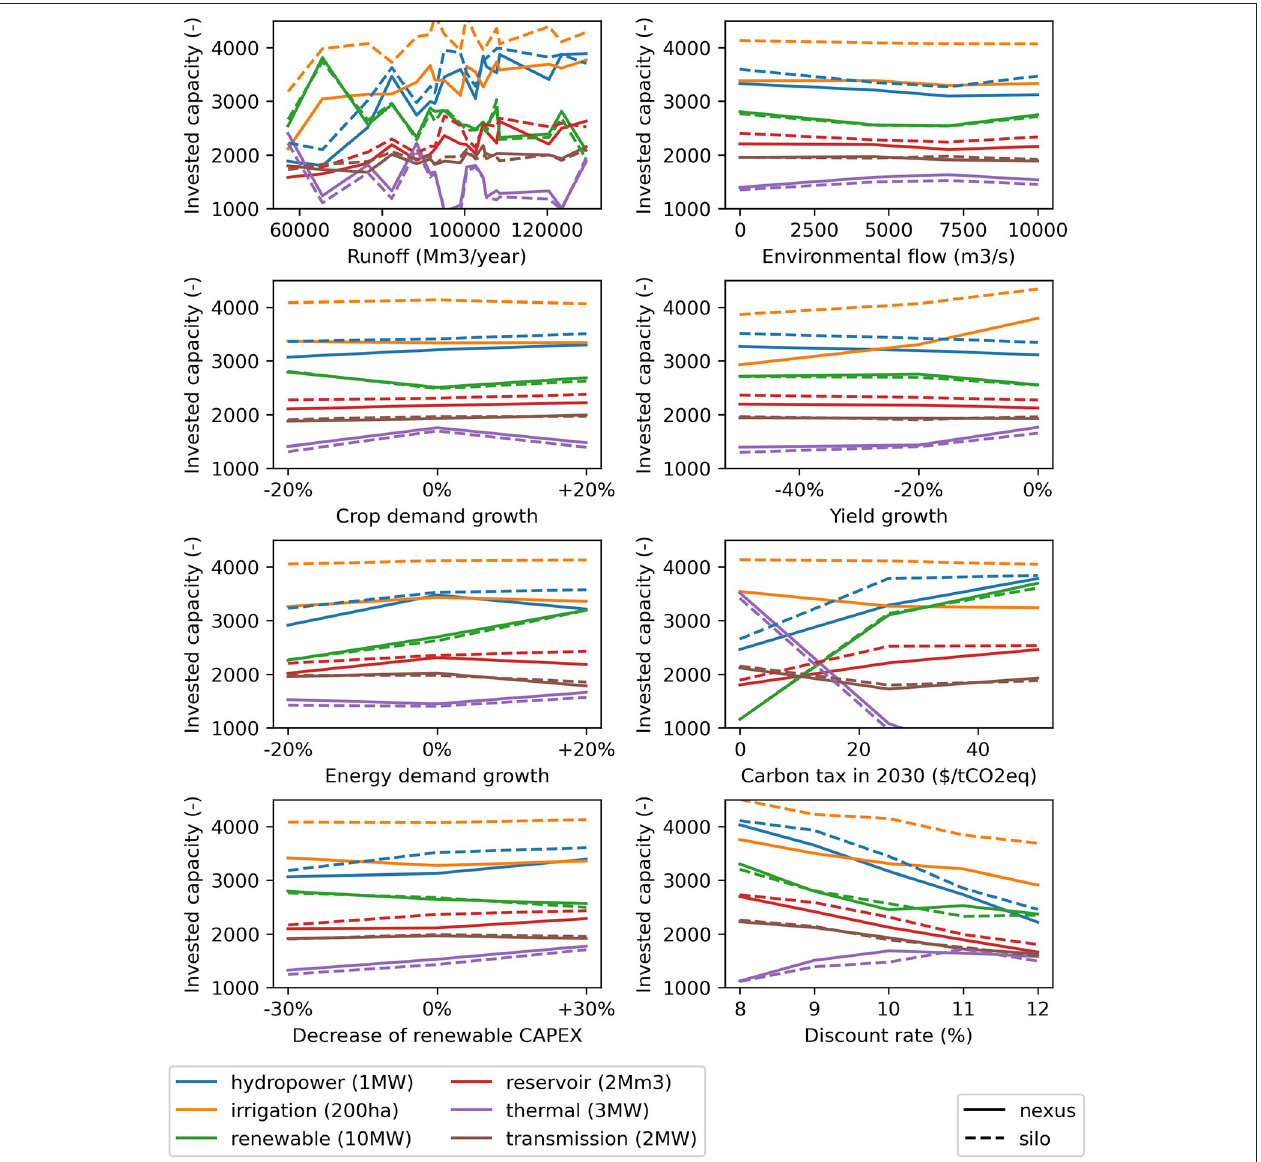
FIGURE 10 | Sensitivity of average invested capacity to uncertain parameters. The y-axis shows the aggregated capacity per type of selected investments, the x-axis shows the variation in an uncertain